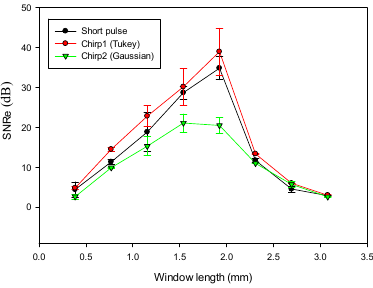
Figure 19. SNRe as a function of correlation window length.